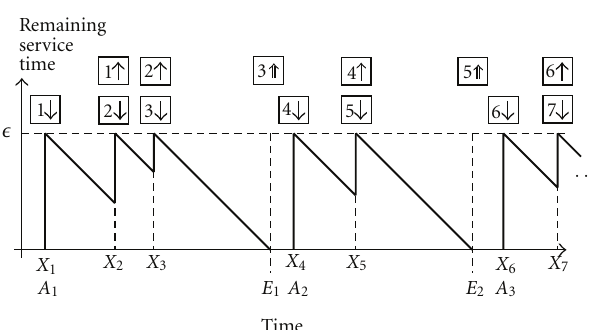
Figure 1: Queueing representation of the model. A down arrow denotes that user i starts his service. An up arrow indicates that user i leaves the system without having finished the service. A double up arrow illustrates that the service of user i finishes. Beginning and end of the i th busy period, respectively, A i and E i , are also shown.